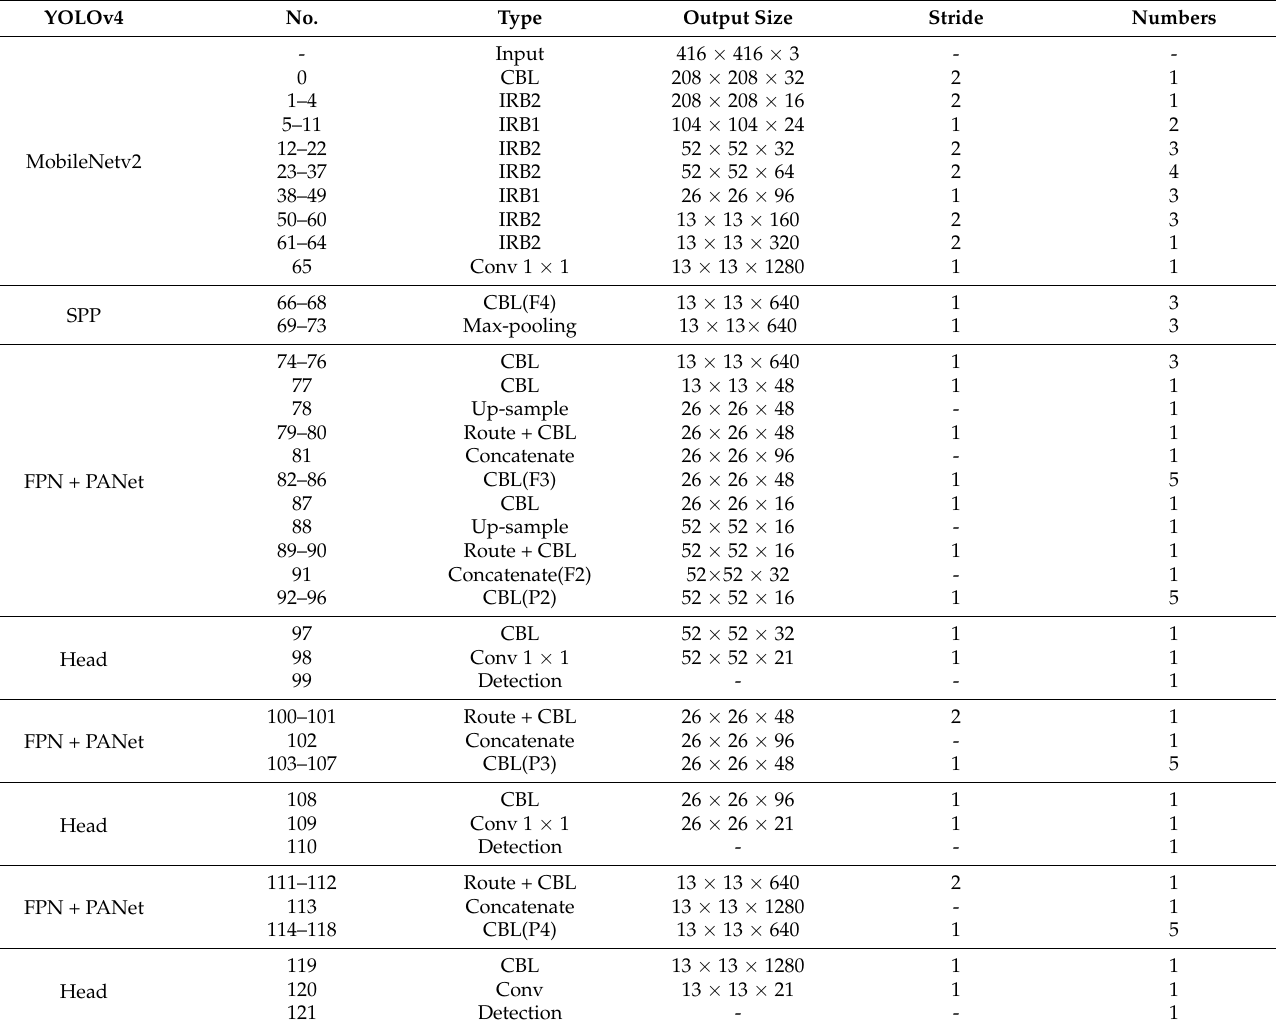
Table 1. YOLOv4-LITE network